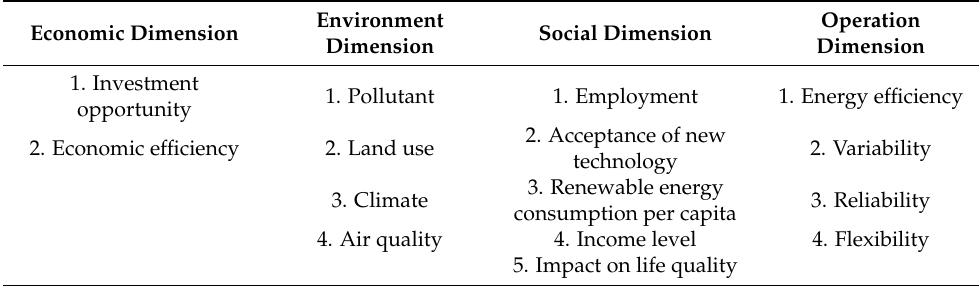
Table 7. Sustainability indicators of an active distribution network (ADN).